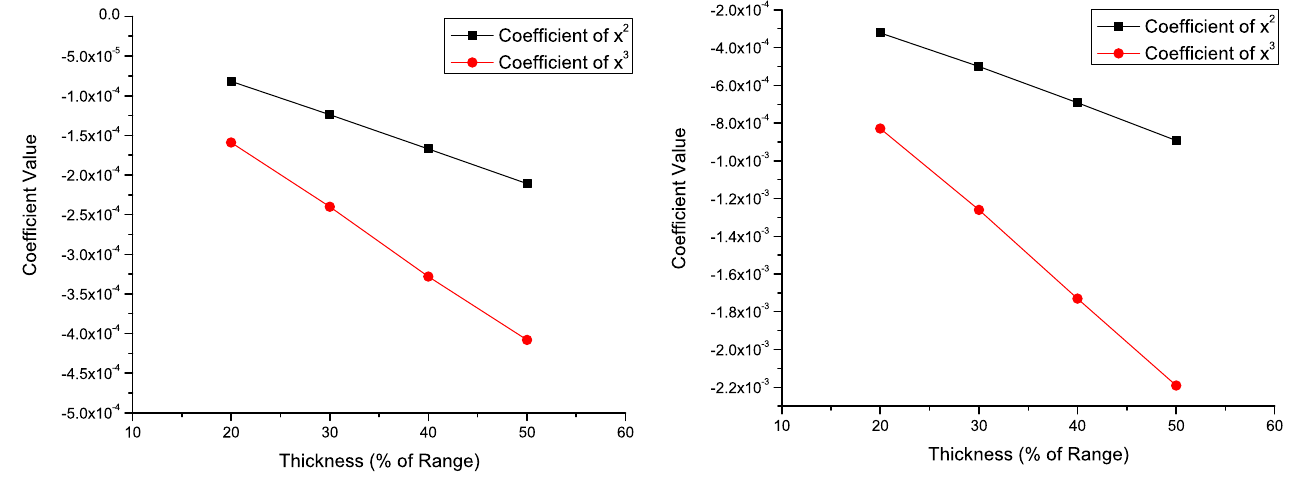
Fig. 9. Notice that at lower energies less curvature is needed. Also, as a function of wedge material the curvature varies with Z . Figure 10 presents the case of Al and Ta for 200 MeV = u beams. Although for lighter wedges and par- ticles more curvature is needed, the absolute values are so small as to make the manufacturing of the wedges at these tolerances very difficult, requiring submicron machining precision.